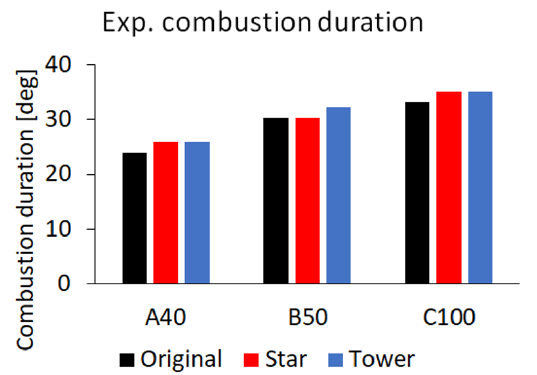
Figure 7. Comparison of the experimental combustion durations for the three operating points when using the three different piston